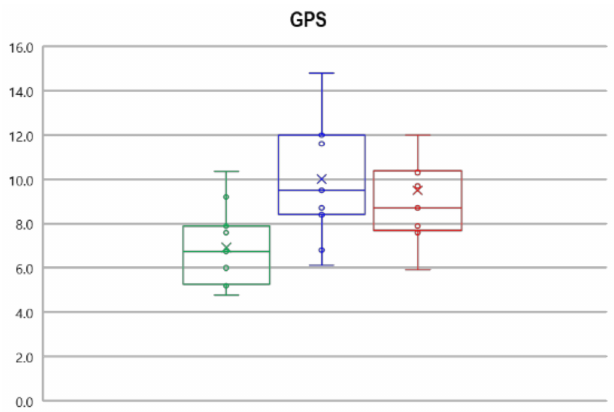
Figure 4. Box plot summarizing the values of GPS for each group considered. The green line represents the control group, the blue line represents the unaffected limb of individuals with OA, and the red line represents the affected limb of individuals with OA.